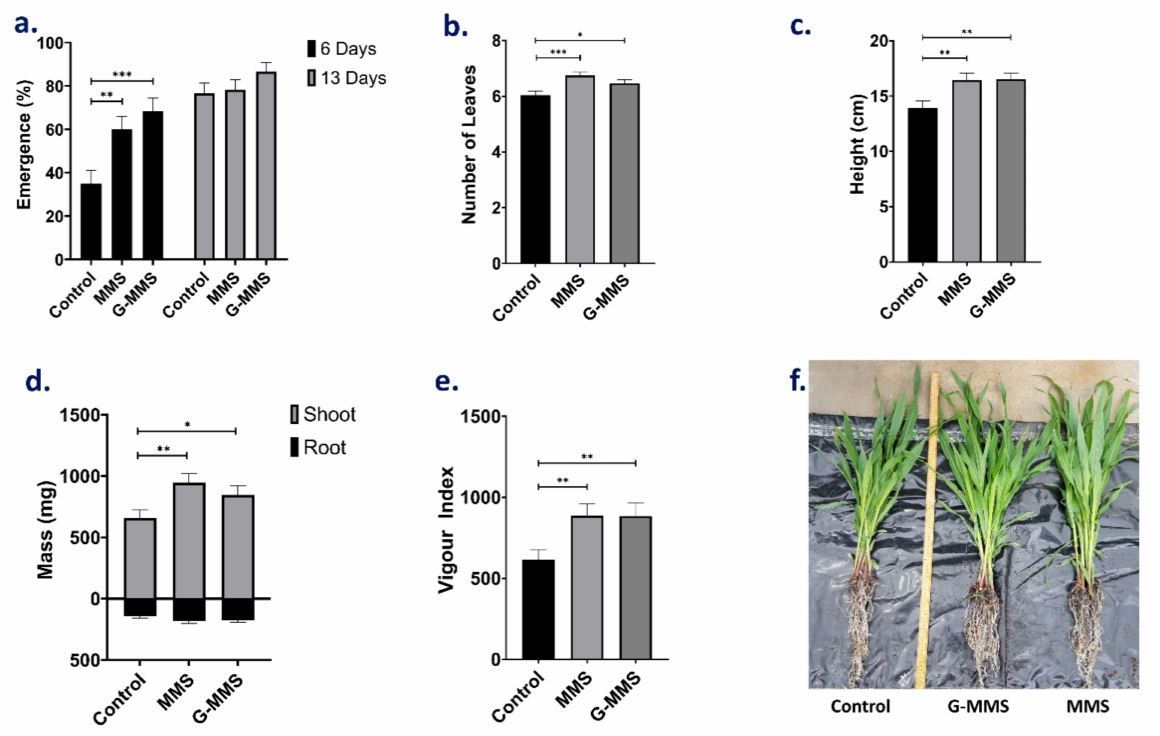
Figure 7. Response of maize ( Zea mays L.) to SOS3 inoculation. The seeds were grown in glasshouse conditions for 22 days before harvest. Each treatment had 28 replicates: one seedling per pot. ( a ) Seedling emergence at 6 and 13 days of untreated maize seeds (control) compared with seeds inoculated with SOS3 grown in MMS (MMS) or SOS3 grown in glucose-MMS (G-MMS); ( b ) analysis of leaf number at harvest; ( c ) height of seedlings at harvest; ( d ) dry biomass; ( e ) vigour index; ( f ) maize plants at harvest after removal from pots and washing of the roots. Error bars denote standard error from the mean, and asterisks indicate statistically significant differences from the control: *, p < 0.05; **, p < 0.01; ***, p <